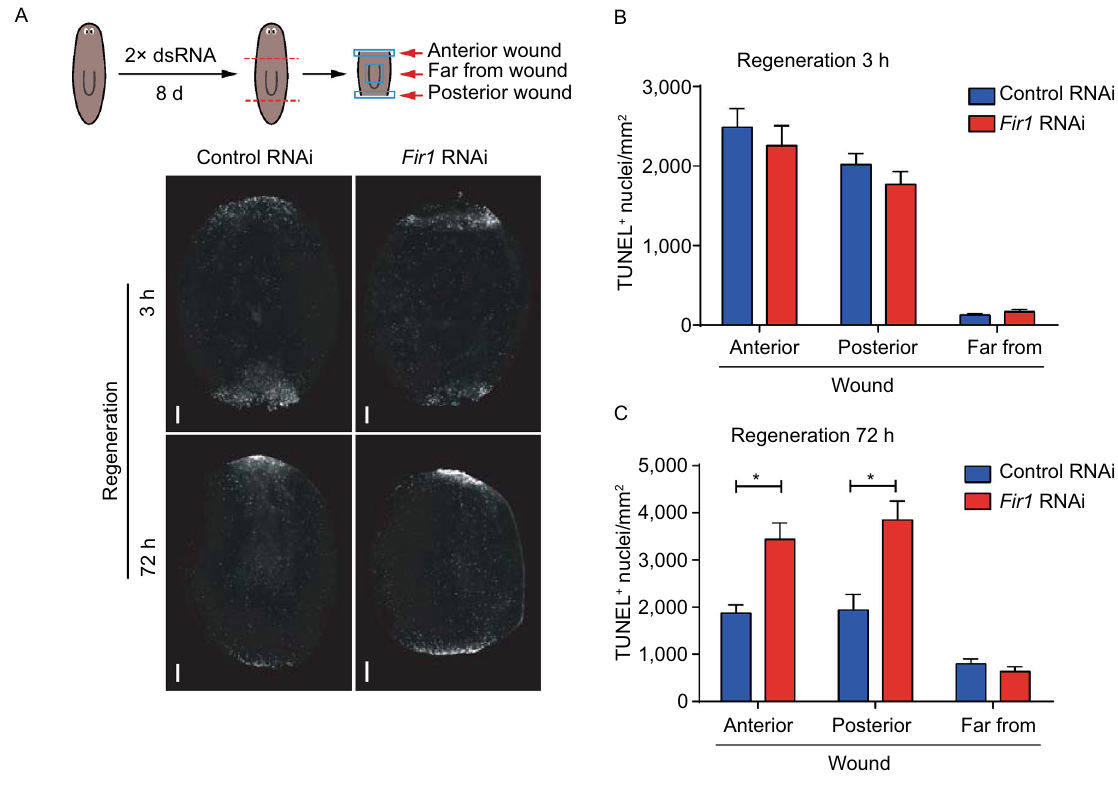
Figure 7. Fir1 (RNAi) animals display abnormal apoptotic pattern during regeneration. (A) The apoptosis in Fir1 (RNAi) trunk pieces 3 h and 72 h post-amputation ( n = 8/8). Scale bars, 200 μ m. (B and C) Quanti fi cation of TUNEL + cells at anterior, posterior and far from wound in Fir1 (RNAi) trunk pieces 3 h and 72 h post-amputation respectively. Error bars represent SEM; Student ’ s t test: * equals P